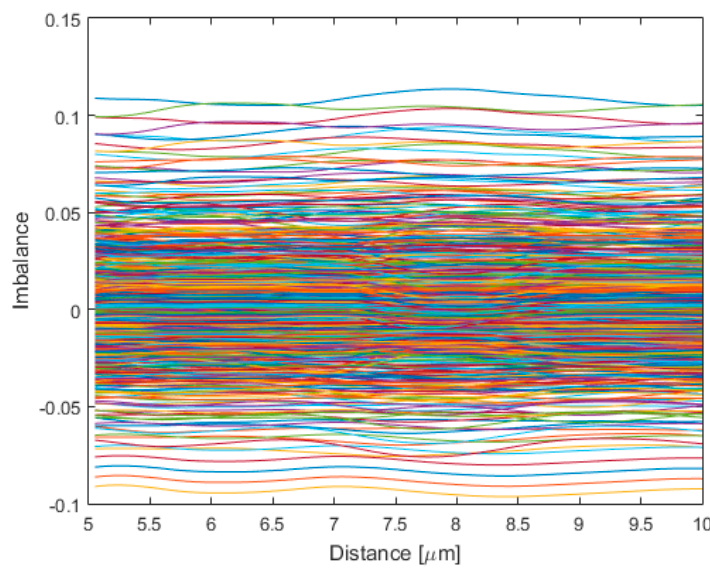
Figure 4. Imbalance along the last 5 µm of propagation in output waveguides for all 750 samples.